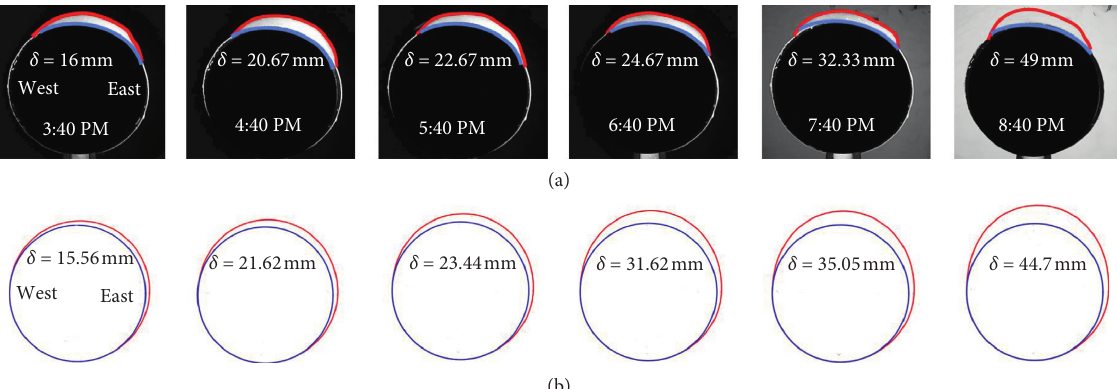
Figure 5: (a) Snow accumulation on cable stays progressively showing an increase in the thickness of the accumulated snow from left to right. (b) Simulation results of wet snow accumulation on cable stays. Diameter of the cables in these experimental and simulation studies is D � 20cm.